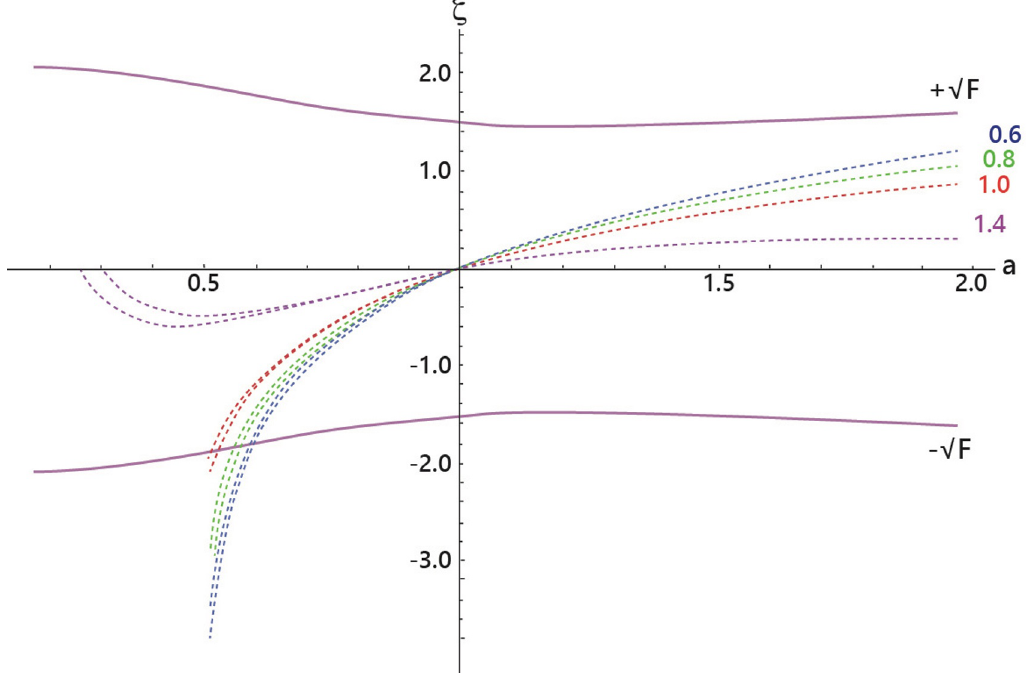
Figure 3 . The dotted curves represent the trajectories of (cid:16) ( a ) (cid:17) _ G=GH for scalar (cid:12)eld dark energy with potential V ( (cid:30) ) = V 0 e (cid:21)(cid:30) , where the value of (cid:16) ( a = 1) is (cid:12)xed so that _ G=GH today is consistent within 3 (cid:27) of the current limits on the instantaneous variation of G ; see eq. (4.12). The (cid:6)p curves labeled F correspond to the NEC violating boundaries; that is, (cid:16) -trajectories that cross these curves must violate the null energy conditions in addition to having time-varying G and time- varying extra-dimensions. Trajectories are shown for (cid:21) = 0 : 6; 0 : 8; 1 : 0; 1 : 4. These all correspond to models that satisfy the Swampland-based constraints; but only the case with (cid:21) (cid:20) 0 : 6 also satis(cid:12)es the observational constraints on w DE ( z ) shown in (cid:12)gure